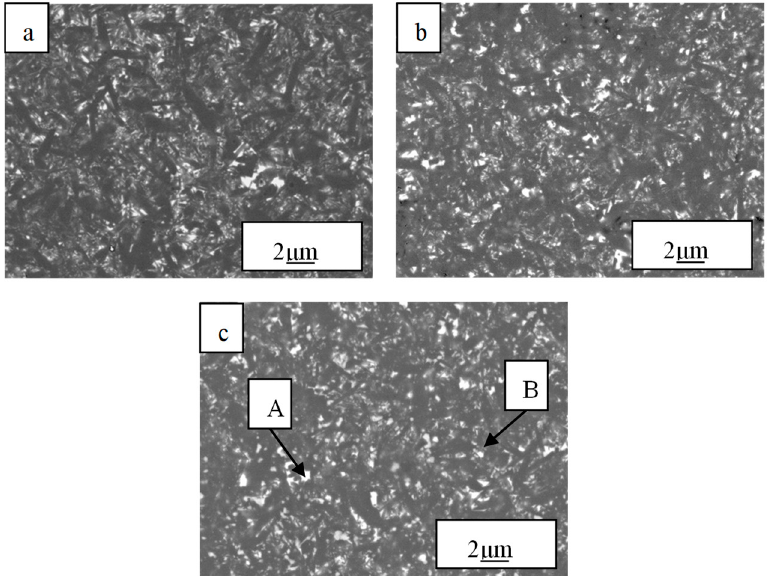
Figure 4. Backscattering photos of the polished surface of samples with different TiC 0.7 N 0.3 contents: